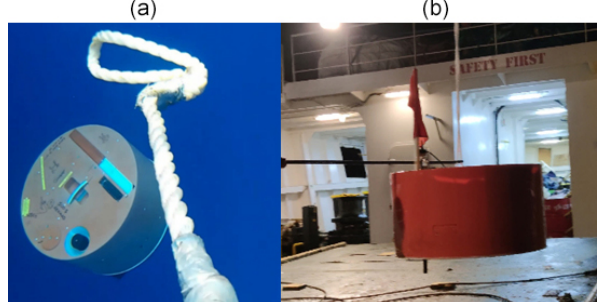
Figure 5. DUNE OBS – new broadband OBS developed and built in Portugal with the new seismic sensor Aquarius (120s–100Hz) from Güralp and a broadband hydrophone HTI-04-PCA. On the left DUNE OBS on free fall in the water column and, on the right, re- covery of the DUNE OBS with the flag, radio and flashlight outside the orange shell. The deployment and recovery on board the Por- tuguese vessel RV Mário Ruivo